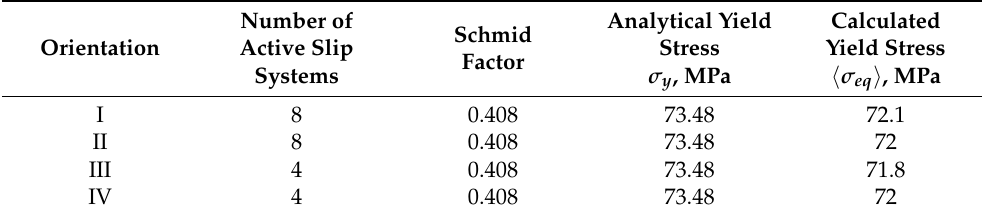
Analytical and calculated yield stresses in aluminum single crystals with different orientations.